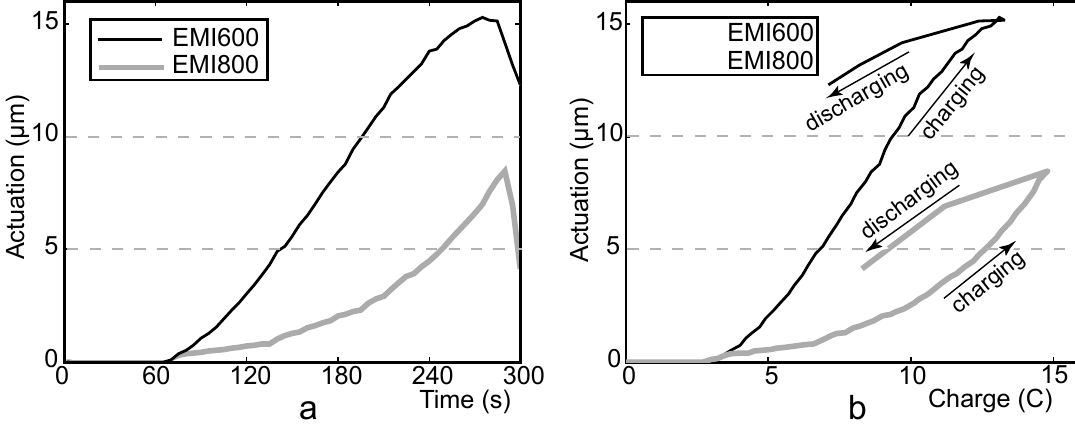
Figure 9. Actuation of EMI600 and EMI800 vs . time (a) and vs . charge (b) (I